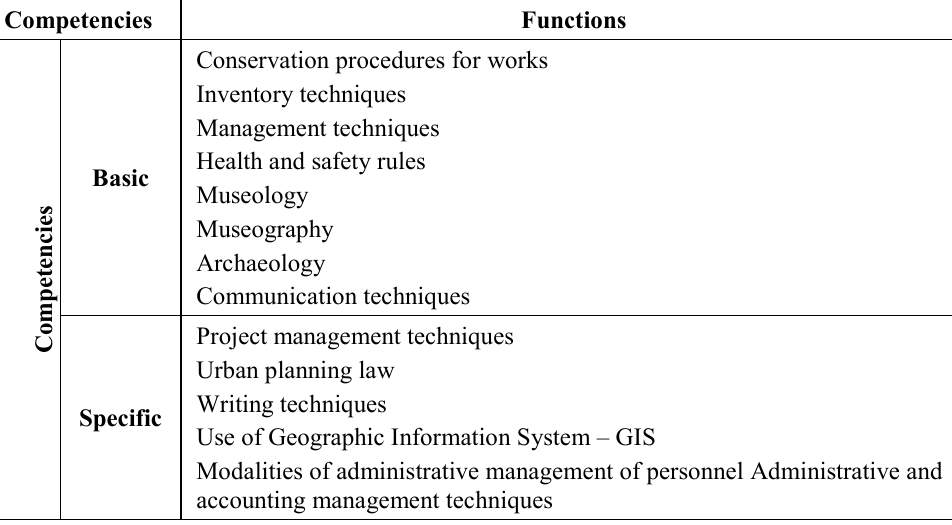
Table 4. Competency Framework of Urban Planner Trade on the ANTP